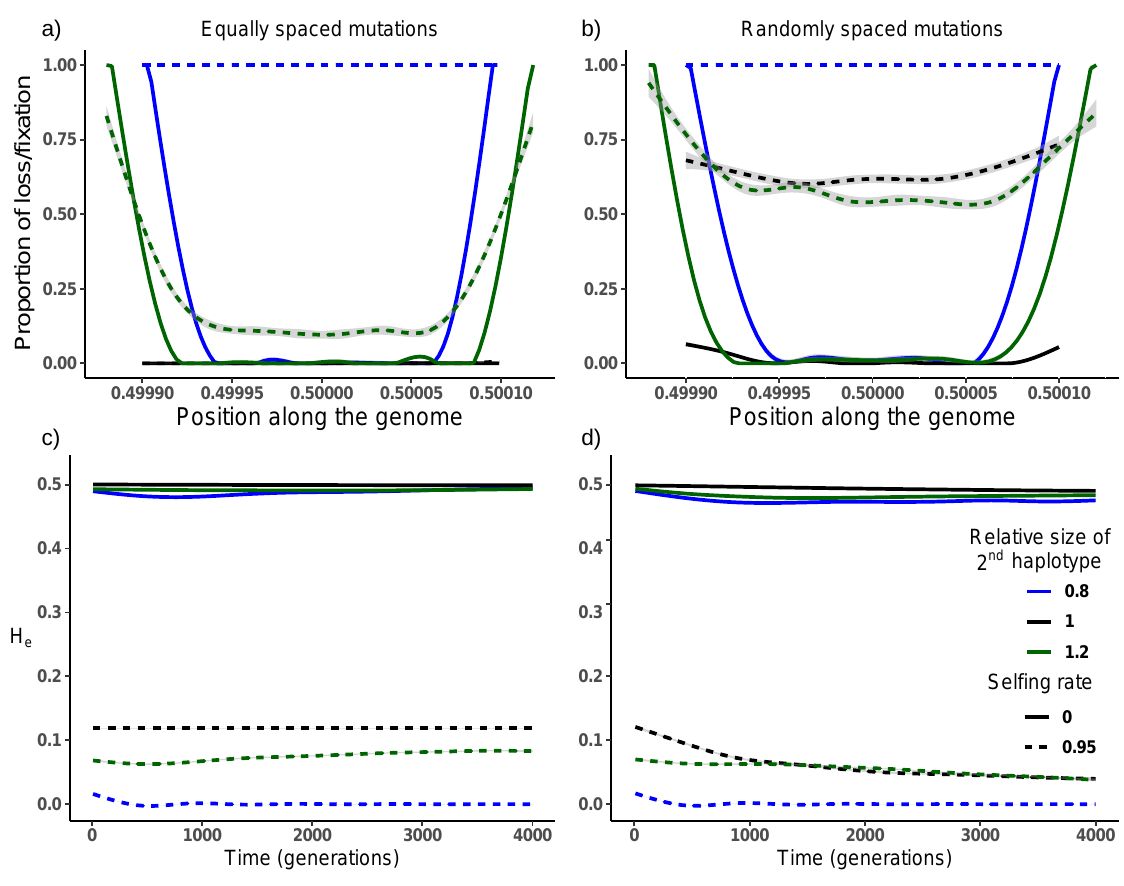
Figure 3 – Effects of relaxing the assumptions of symmetric overdominance and evenly spaced mutations. Upper panels show locations within the POD zone where load mu- tations are most likely to be lost (a, b) and how this depends on whether mutations are evenly spaced (a) or randomly distributed (b). Results are shown for both symmet- ric (black) and asymmetric (green and blue) loads. Outcomes under both outcrossing and high selfing (solid vs. dotted lines) are shown. Note erosion of mutations via recombina- tion and selection at both ends of the POD zone. Lower panels show overall stability of the POD zone (shown as heterozygosity, He ) over time. As in the upper panels, graphs show results for both symmetric (black) and asymmetric (green and blue) loads and for evenly and randomly placed mutations (panel c vs. d). The coefficients of selection and dominance are s = 0.01 and h = 0.2 respectively, linkage within the POD zone is ℓ = 10 − and population size N = 1000